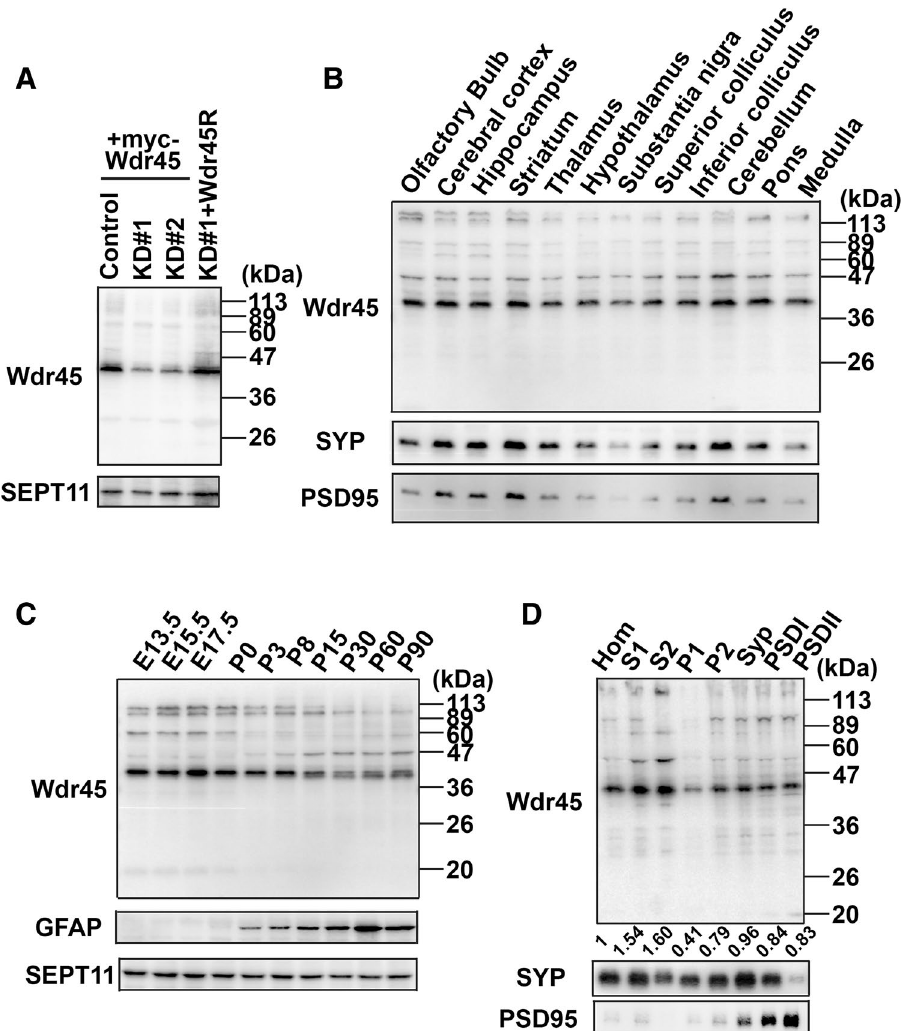
Figure 1. Expression profiles of Wdr45 in mouse tissues. ( A ) Characterization of anti-Wdr45. COS7 cells were transfected with pSuper-Luc (control), pSuper-Wdr45#1(KD#1) or -Wdr45#2 (KD#2) together with pCAG- Myc-Wdr45 or -Myc-Wdr45R. After 48 h, cells were harvested and lysates were subjected to western blotting using anti-Wdr45. The blot was probed with anti-Sept11 as loading control. ( B ) Regional expression of Wdr45 in brain. Various regions were dissected from adult mouse and whole tissue extracts were prepared as in “Materials and methods” section. Each extract (20 µg of proteins) was subjected to western blotting using anti-Wdr45, anti-synaptophysin and anti-PSD95. ( C ) Whole brain lysates (30 µg protein per lane) at indicated developmental stages were subjected to western blotting with anti-Wdr45. GFAP and Sept11 were used as differentiation marker and loading control, respectively. (D ) Subcellular fractions (30 µg protein per lane) prepared from adult forebrains by differential and density-gradient centrifugation were subjected to western blotting with anti-Wdr45. Anti-synaptophysin (SYP) and anti-PSD95 were used as presynaptic and postsynaptic markers, respectively. The relative levels of the ~ 40 kDa band were measured by densitometry and shown as fold-increase compared to the expression level of the homogenate. Hom homogenate, S1 soluble fraction, S2 crude cytosol fraction, P1 nuclear fraction, P2 crude membrane fraction, Syp synaptosomal fraction, PSDI PSD fraction-I, PSDII PSD fraction-II. Uncropped blots are shown in Supplementary Figs.